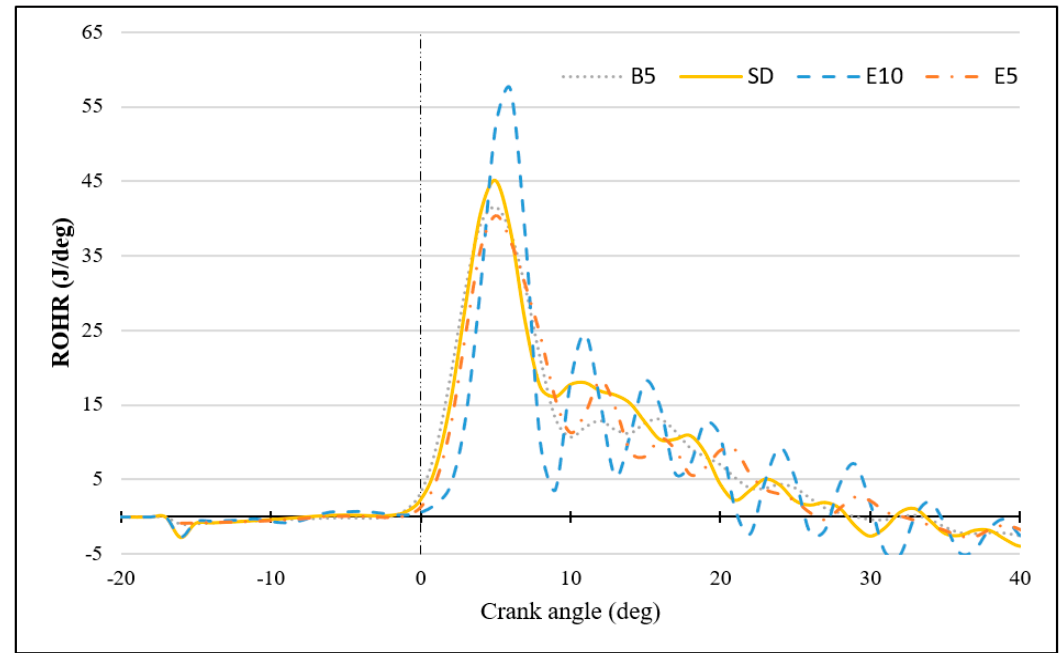
Figure 16. Comparison of the ROHR at 4 kW for various fuels.